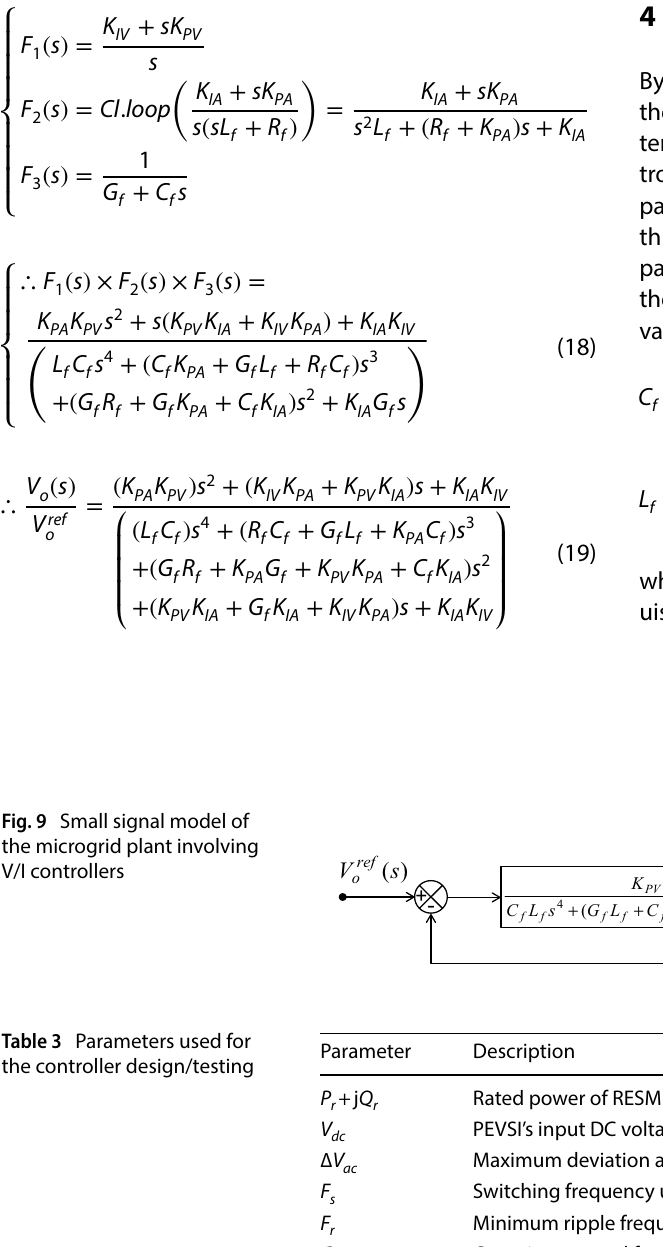
Table 3 Parameters used for the controller design/testing